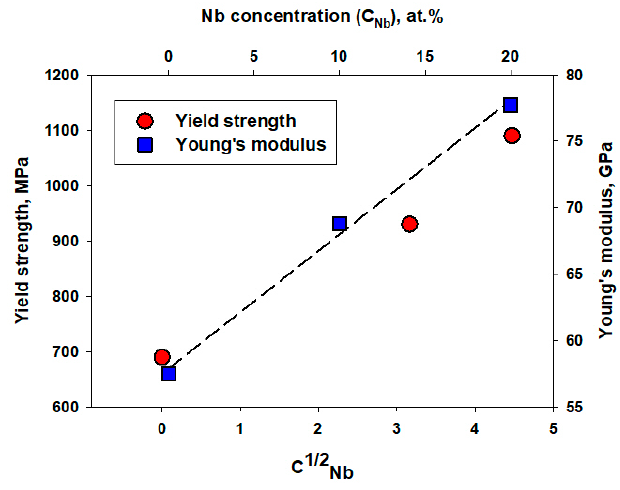
Figure 7. Dependence of the Young’s modulus of the program alloys on Nb percentage (C Nb ) and yield strength on C 1/2Nb .